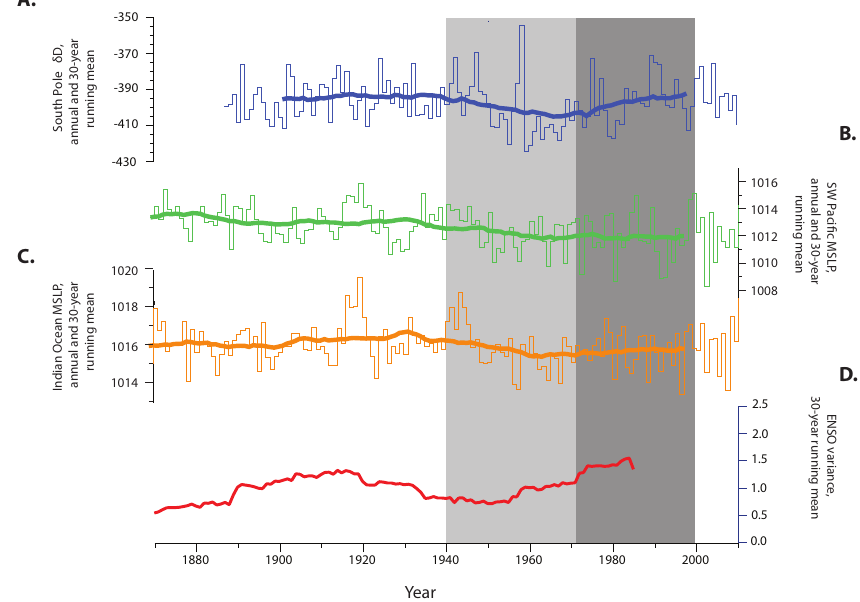
Figure 3. Annual and 30-year running mean of South Pole δ D (a) compared to annual and 30-year running mean sea level pressure (hPa) for the southwestern Pacific (180–160 ◦ W, 55–45 ◦ S) (b) and southern Indian Ocean (80–100 ◦ E, 35–45 ◦ S) (c) extracted from Twentieth Century Reanalysis (Compo et al., 2011), and 30-year variance in El Niño–Southern Oscillation (McGregor et al., 2013) (d) . Light grey column area denotes a period of Indian Ocean MSLP dominance over Antarctic temperatures; the dark grey column denotes the period where the southwestern Pacific MSLP is associated with warming over the geographic South